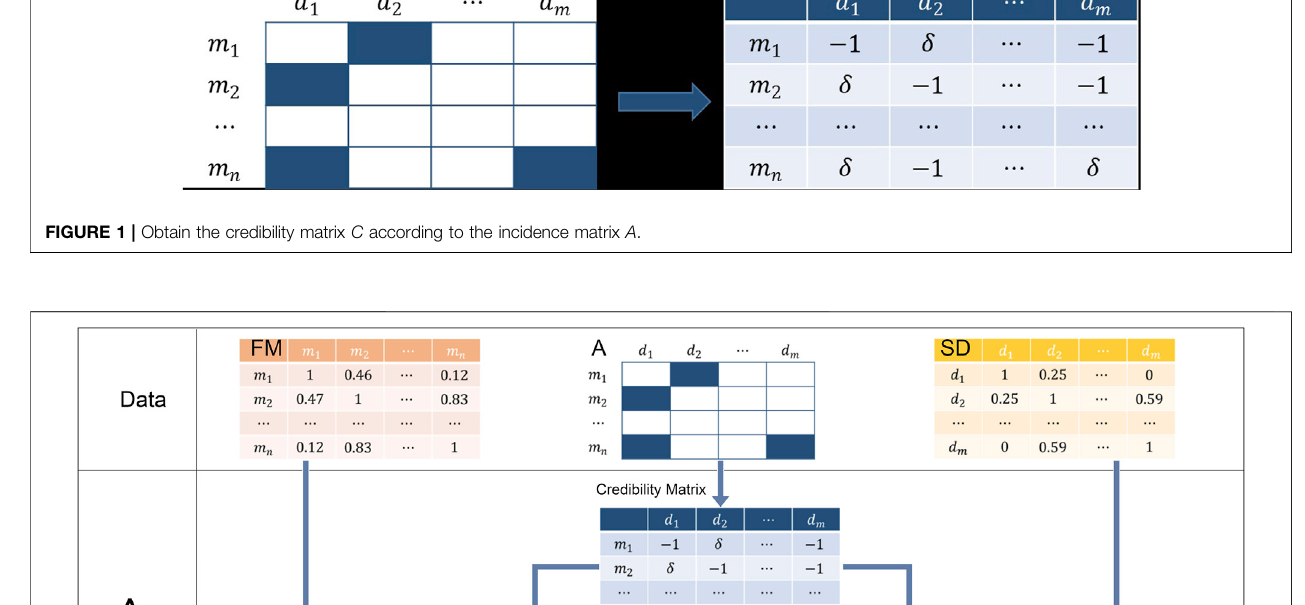
Frontiers in Genetics |